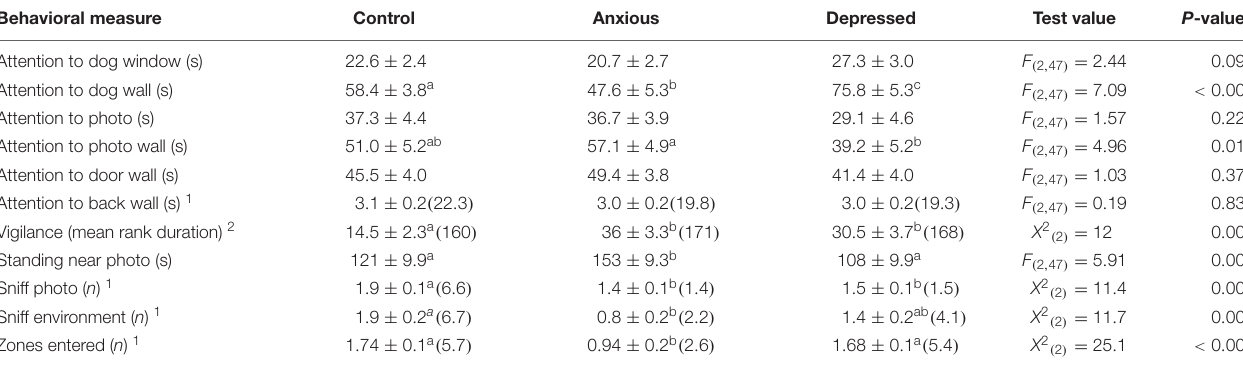
TABLE 5 | Mean ± SEM behavioral responses of sheep in each treatment group during the attention bias test.